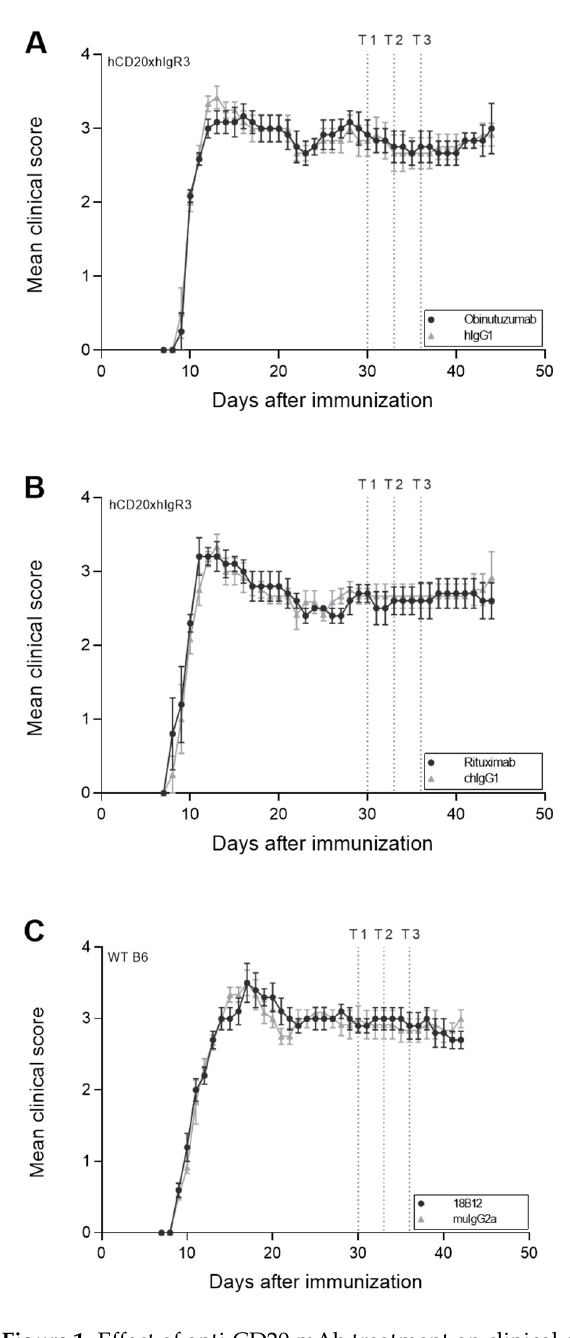
Figure 1. Effect of anti-CD20 mAb treatment on clinical disease in hCD20xhIgR3 and WT B6 mice. EAE was assessed daily in all mice ( n = 5–6 per group) and scores are shown as means ± standard error of the mean. Dotted lines mark the three time points (T1, day 19; T2, day 22; T3, day 25) of treatment with 5 mg/kg anti-CD20 mAb: ( A ) obinutuzumab, ( B ) rituximab, or ( C ) 18B12, or their respective isotype control antibodies (hIgG1, chIgG1, or muIgG2a). Note that treatment started 19 days after the mice had reached an EAE score of ≥ 2.5. Mice were scored using the standard EAE scale ranging from 0 to 5: 0, no signs of disease; 1, limp tail; 2, hindlimb weakness; 3, nearly complete or complete hindlimb paralysis; 4, complete hindlimb and partial forelimb paralysis; 5, moribund. The area under the curve (AUC) was calculated for each group. To evaluate whether there was a statistically significant difference in disease severity between the isotype control- and anti-CD20 mAb-treated groups the p -value of the AUCs was calculated using an unpaired t -test. No statistical significance was observed.